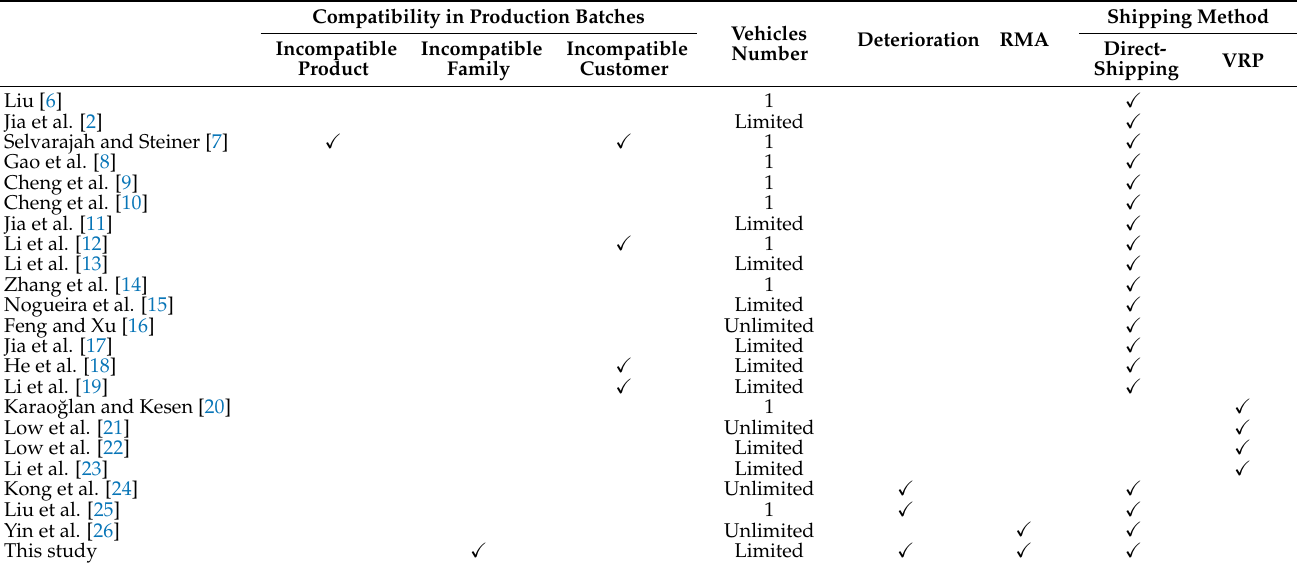
Table 1. Classification for Studies on ISP with batch